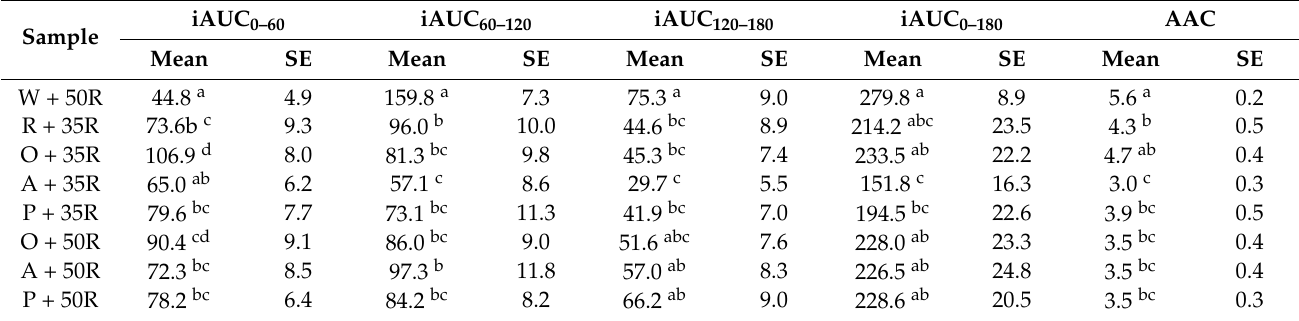
Table 2. PGR characteristics of test meals in 180 min ( n =